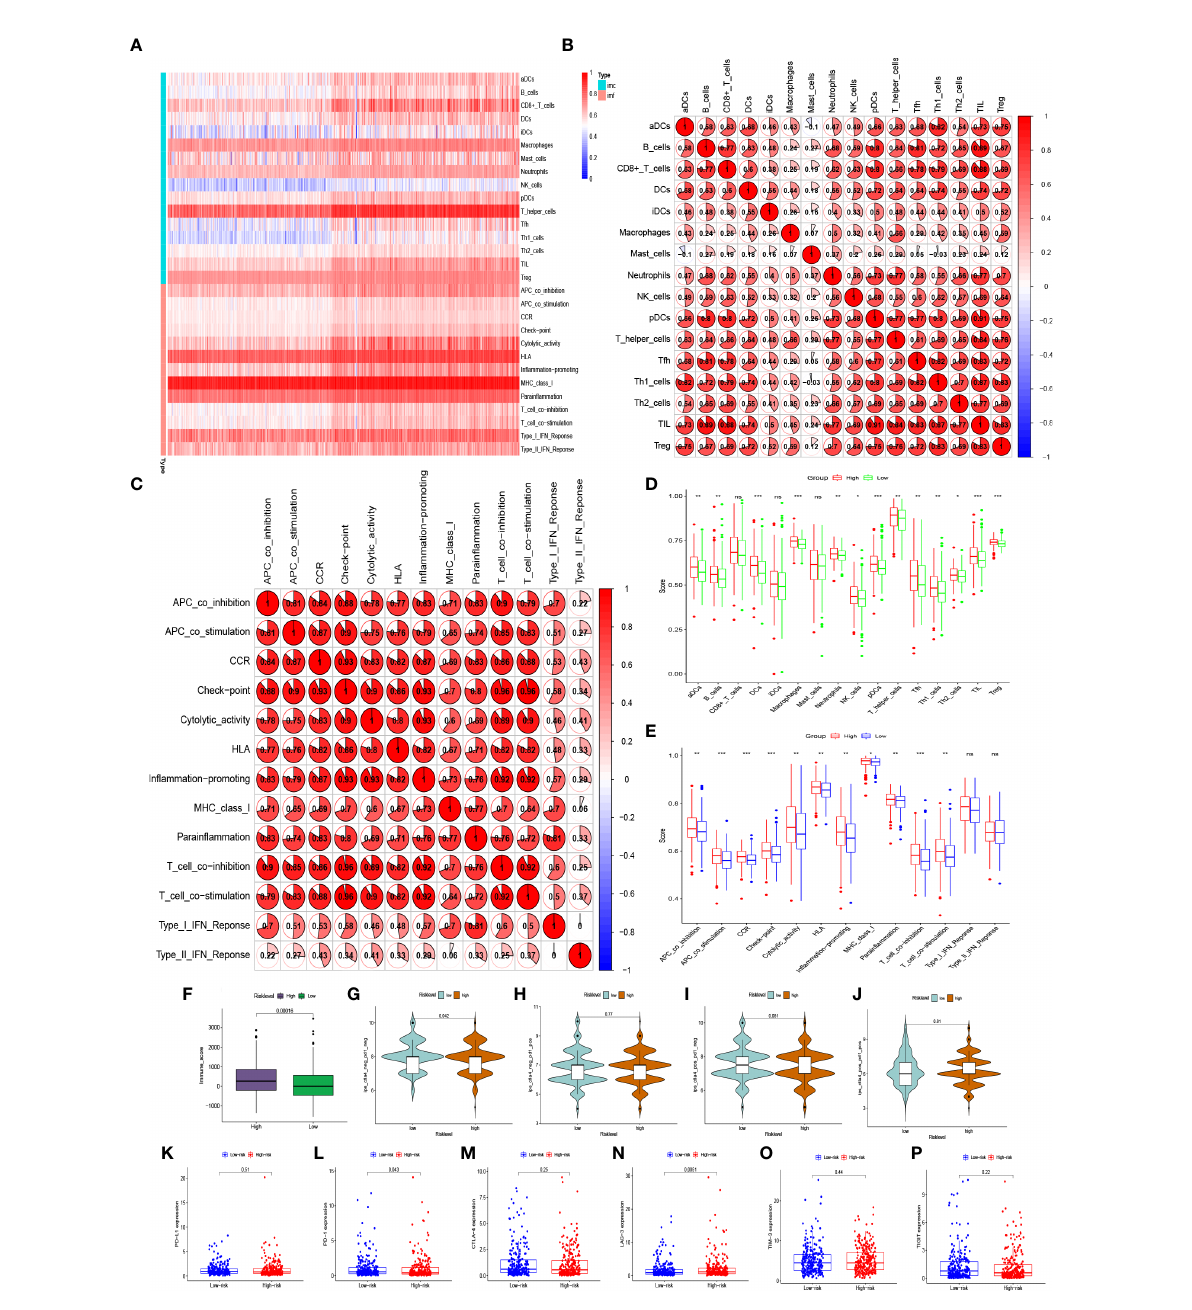
FIGURE 7 Abundantexpressions of immunein fi ltrationinBCpatients. (A) Heatmapof expressionabundances of